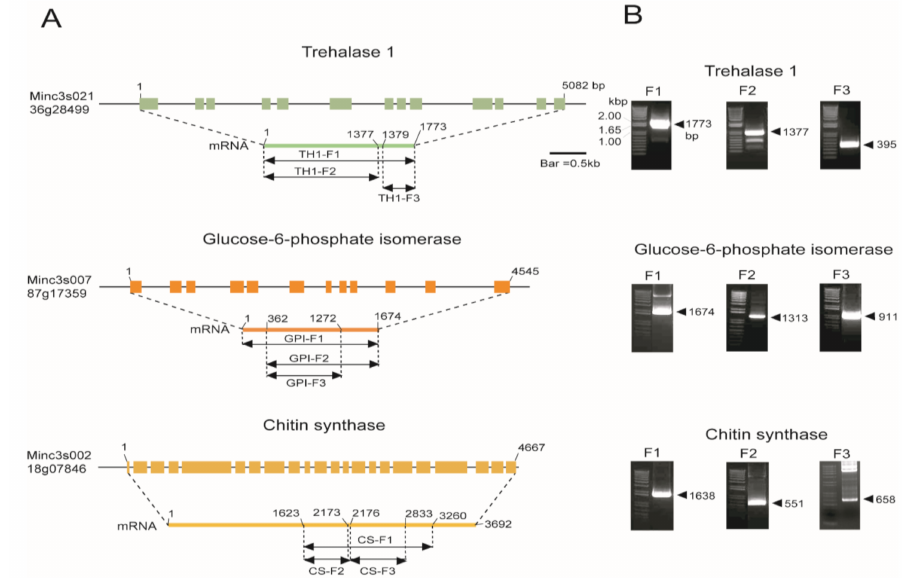
Figure 1. ( A ) Schematic representation of the Meloidogyne incognita genome structure of chitin biosynthesis pathway genes. The three major genes of chitin biosynthesis were predicted from the M . incognita genome as follows: Trehalase 1 (Minc3s02136g28499), glucose-6-phosphate isomerase (GPI) (Minc3s00787g17359), and chitin synthase (CS) (Minc3s00218g07846). ( B ) PCR amplification of di ff erent constructs of the three genes (TH1-F1, 1.7 kb; TH1-F2, 1.3 kb; TH1-F3, 0.3 kb; GPI-F1, 1.6 kb; GPI-F2, 1.3 kb; GPI-F3, 0.9 kb; CS-F1, 1.6 kb; CS-F2, 0.5 kb; CS-F3, 0.6 kb) were isolated from M . incognita and cloned into the PCR TM 8 / GW / Topo TM